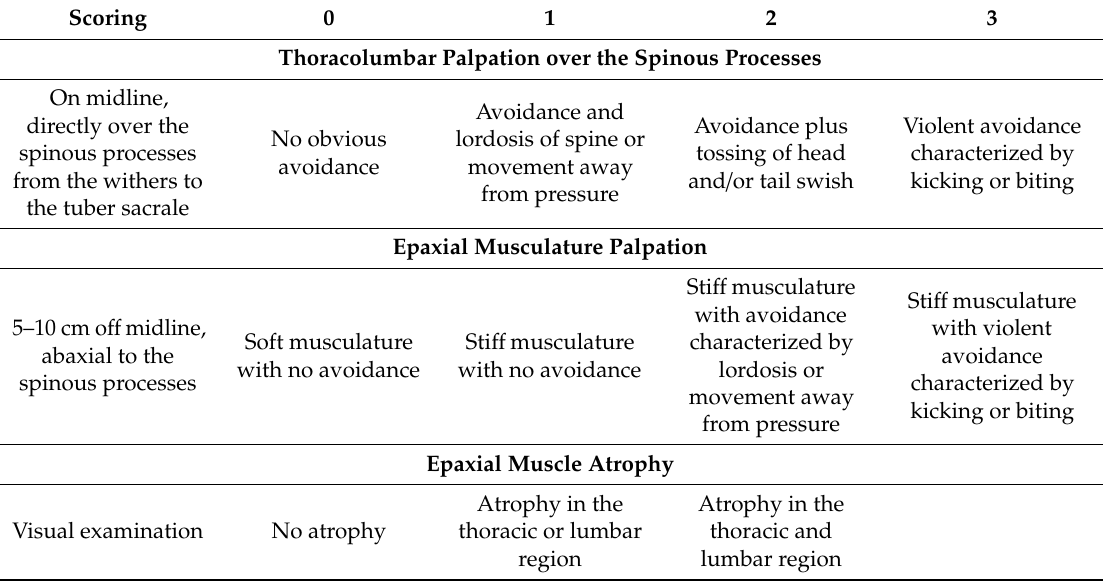
Table 1. Scoring of back examination, considering thoracolumbar palpation over the spinous